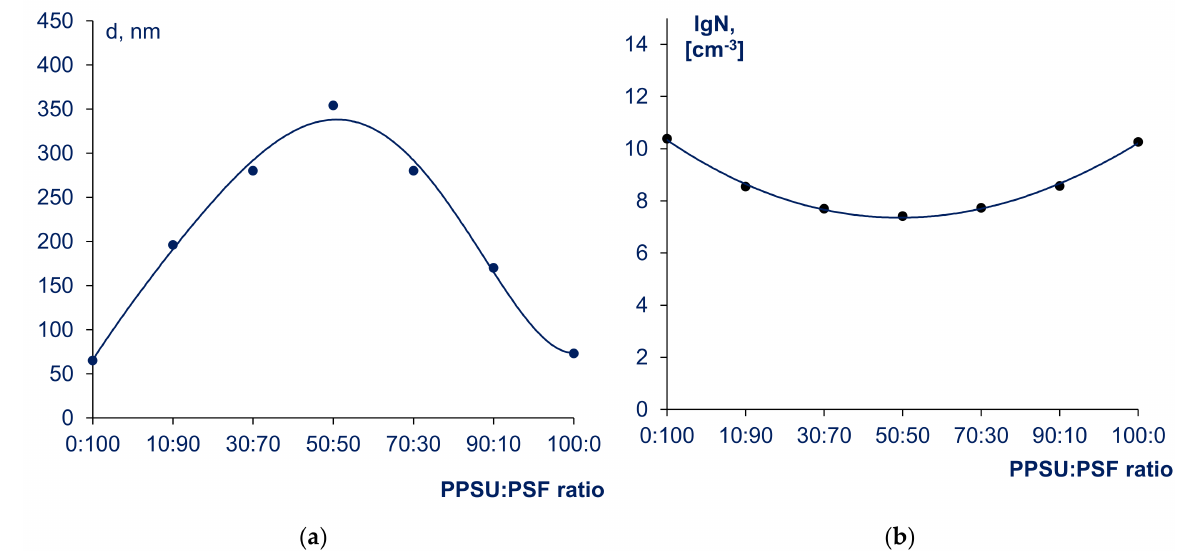
Figure 3. Average diameter (d) ( a ) and logarithm of number (lgN) ( b ) of supramolecular particles (in 1 cm − 3 of solution) vs. the PPSU:PSF blend ratio in the solution with total concentration of polymers 20 wt%.